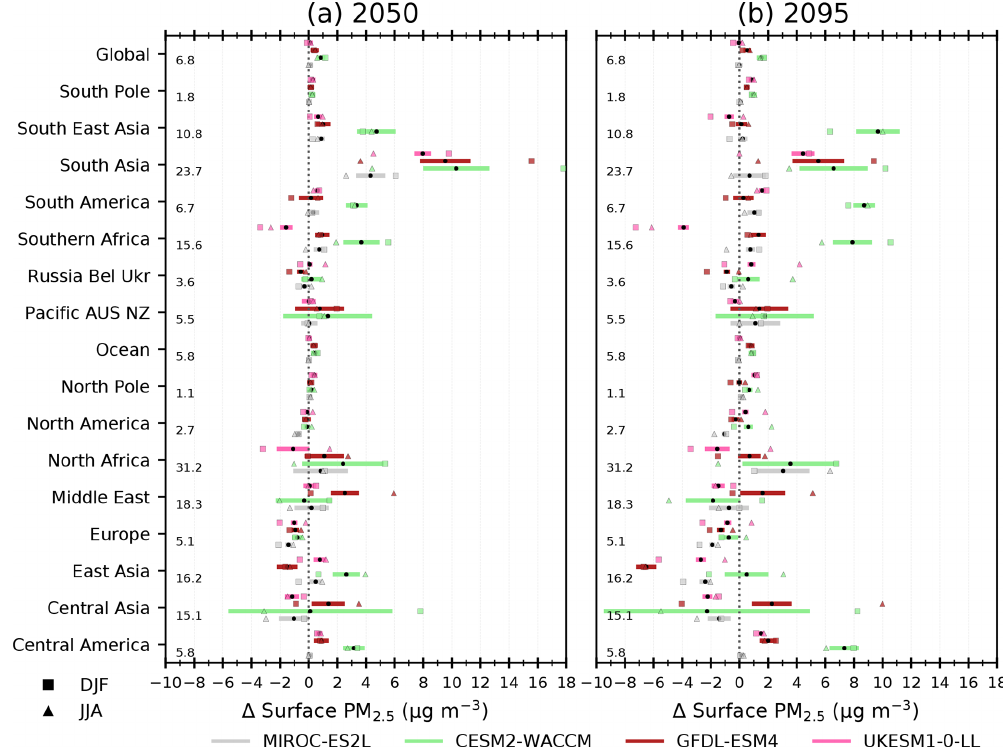
Figure 15. Future global and regional changes in the annual and seasonal mean surface PM 2 . 5 , relative to the 2005–2014 mean, for the ssp370 pathway used in CMIP6. Each black circle represents the annual mean response for an individual model in (a) 2045–2055 and (b) 2090–2100, with the coloured bars showing the SD across the annual mean. The DJF and JJA seasonal mean responses averaged over the relevant 10-year periods are shown by squares and triangles, respectively. The multi-model regional mean over the period 2005–2014 is given towards the left of each